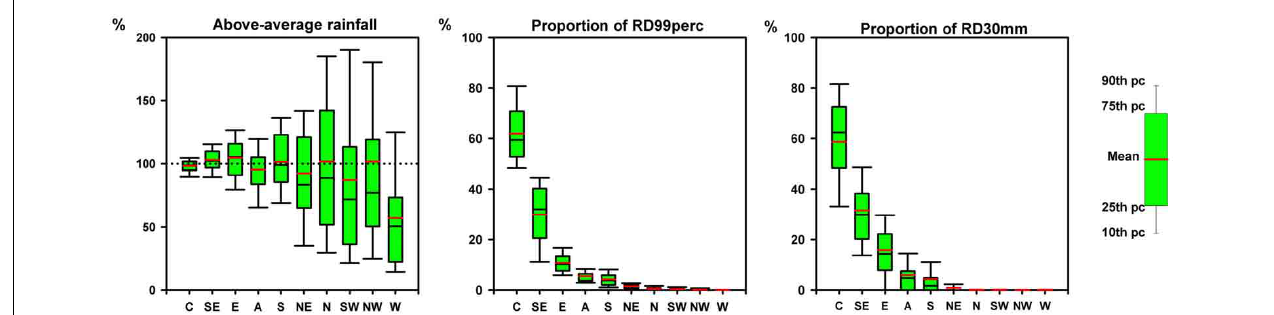
FIGURE 7 | Box plots showing the ratio of the average of rainfall totals falling during days of each weather type and those falling in all rainy days (left). Also, the relative frequency (%) of RD99 perc days (middle) and RD30 mm days (right) corresponding to each weather type is plotted. All